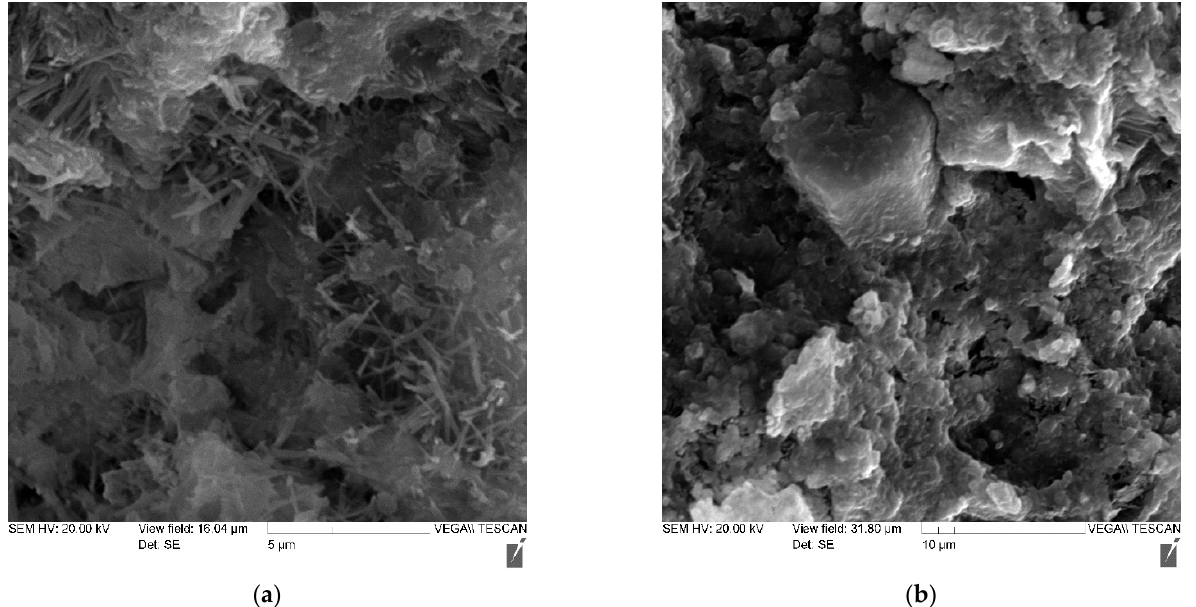
Figure 10. Photo of the microstructure of a cement stone with an MS-85 additive in an amount of 10% and an additive of MELFLUX 5581 superplasticizer: ( a ) with 2000× magnification ( b ) with 1000× magnification.